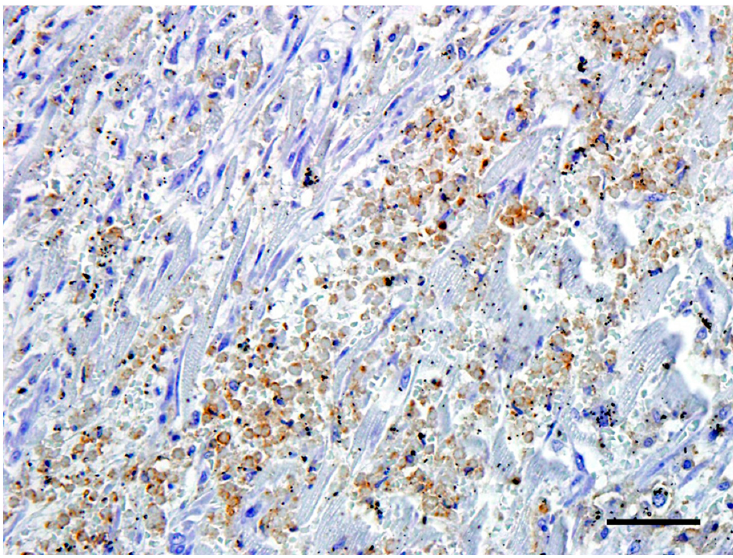
Figure 4. The neoplastic cells in the heart exhibited a mild to marked diffuse cytoplasmic staining for CD18. Bar = 50 µm.